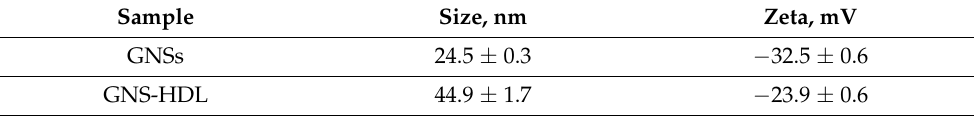
Figure 1. Characterization of GNSs and GNS-HDL. ( a ) Schematic diagram of the GNS synthesis process and the coating of GNS with m-PEG (85%) and COOH–PEG (15%), followed by covalent conjugation with HDL. ( b ) FT-IR spectra of GNSs (thin line) and GNS-HDL (bold line). The peaks around 950 cm − 1 are the major proof of the formation of the C–N bond. ( c ) Optical properties of GNSs: ultraviolet-visible spectroscopy of bare GNSs (solid line) and HDL coated GNSs (dotted line), both presenting an absorption peak at 530 nm. Inset: TEM image of the 20 nm gold nanospheres. Table 1. Zeta potential and dynamic light scattering (DLS) size measurements (at 25 ◦ C) of bare GNSs and HDL coated GNSs. The significant difference that was obtained (by zeta potential, DLS and UV-vis spectroscopy) following coating demonstrates the efficiency of the chemical